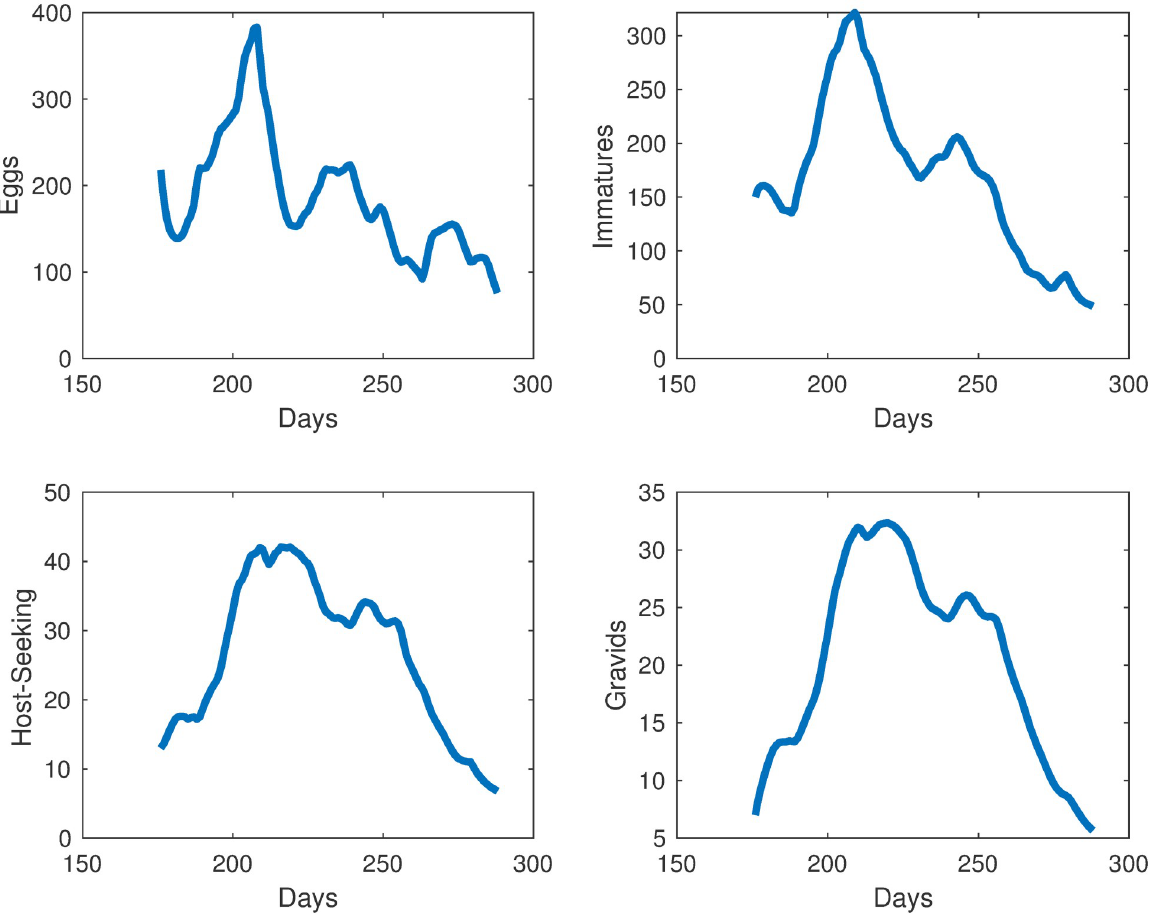
Fig 3. Simulations of mosquito population at different life stages in Knoxville,